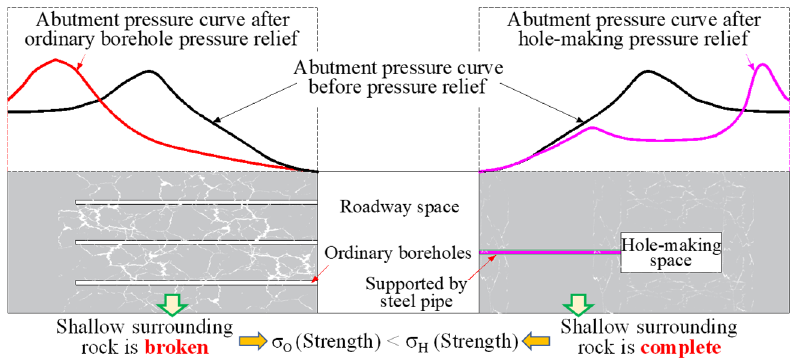
Figure 1. Comparison between the internal hole-making pressure relief technology and conventional pressure relief technology of surrounding rock.